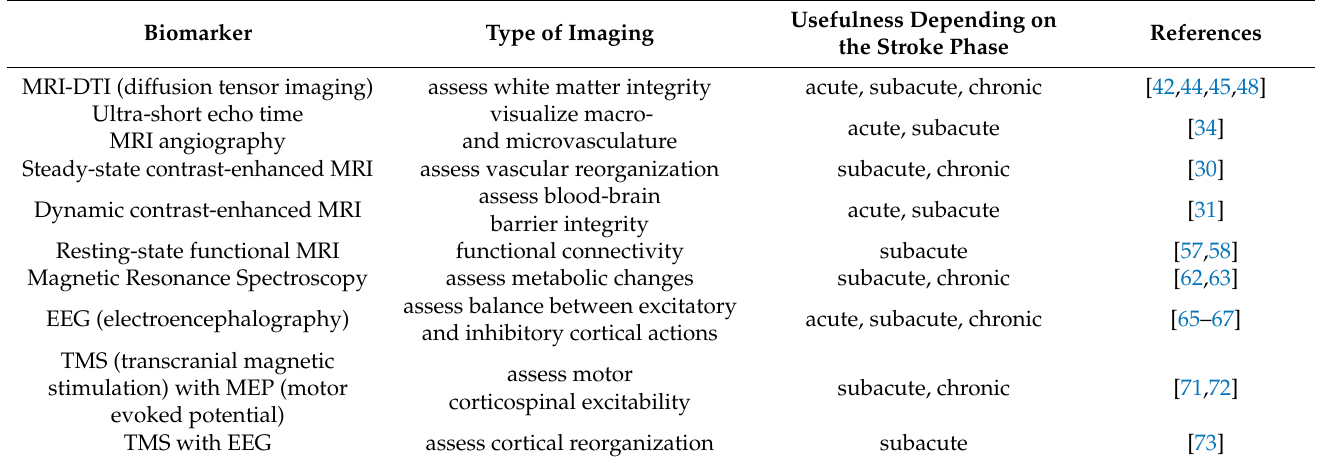
Table 1. Selected neuroimaging biomarkers of stroke